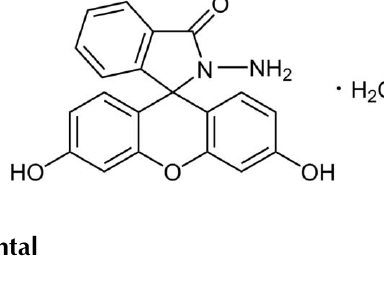
Experimental Crystal data